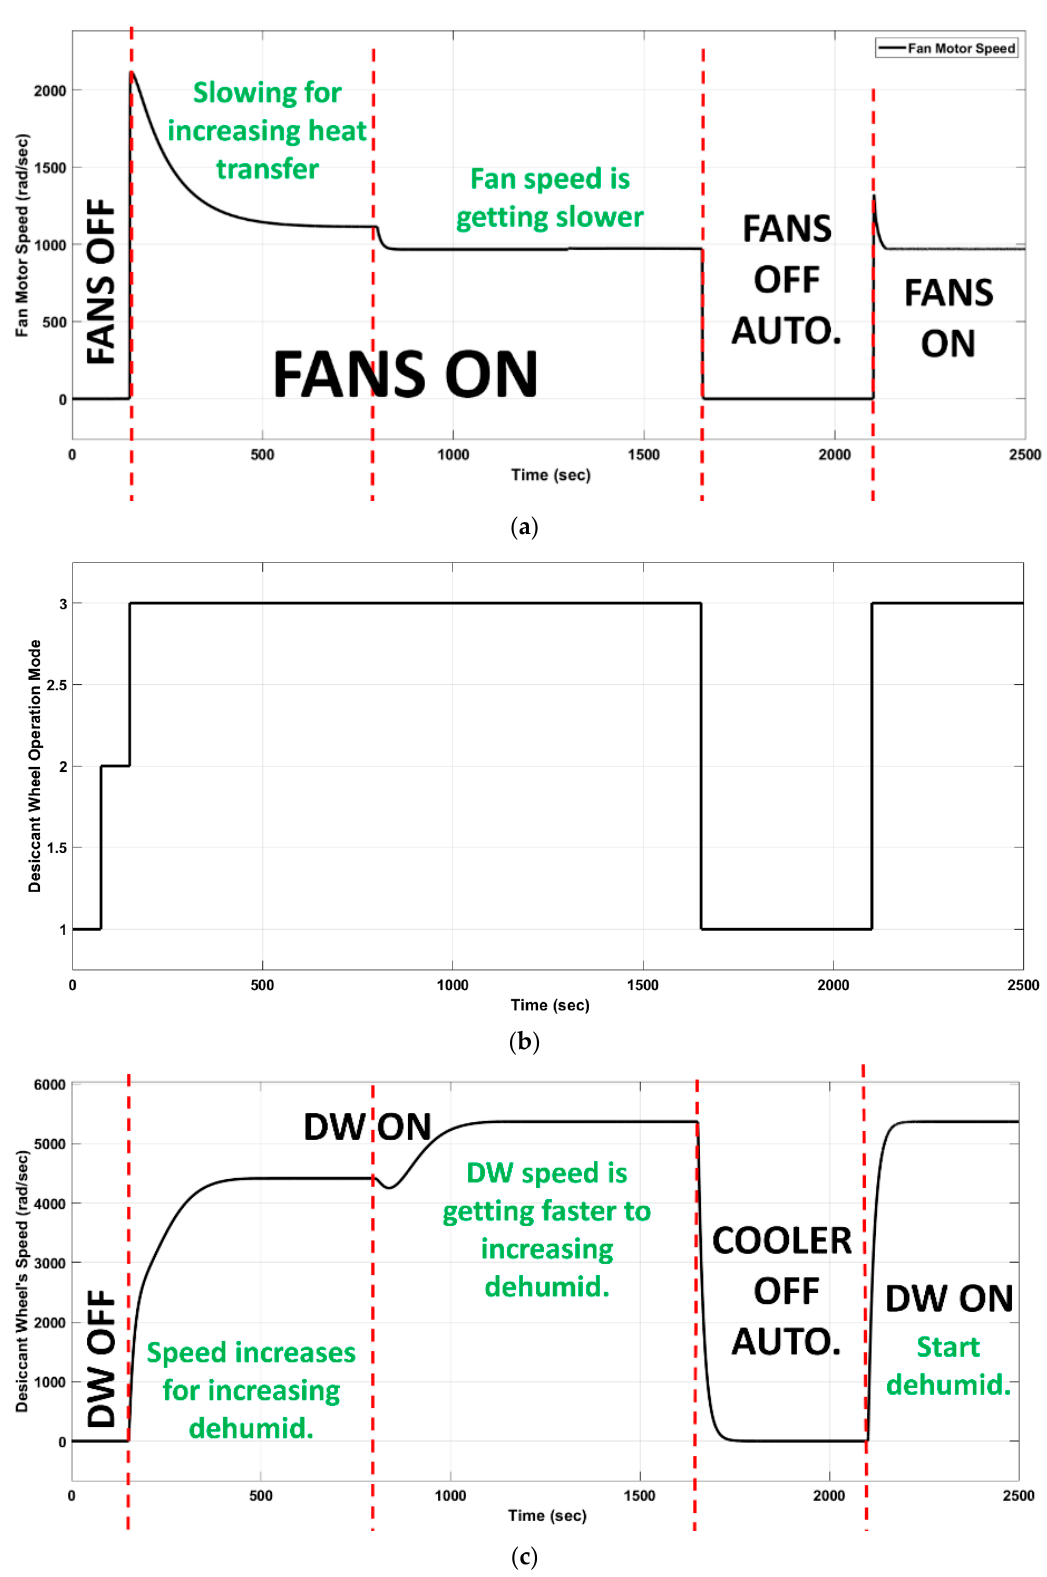
Figure 4. ( a ) The rotational speed of fans. ( b ) The operation modes of the desiccant wheel. ( c ) The rotational speed of the desiccant wheel. After that, the powers and the energies consumed by the actuators depending on the actuator voltage values determined by the control strategy according to the ambient and